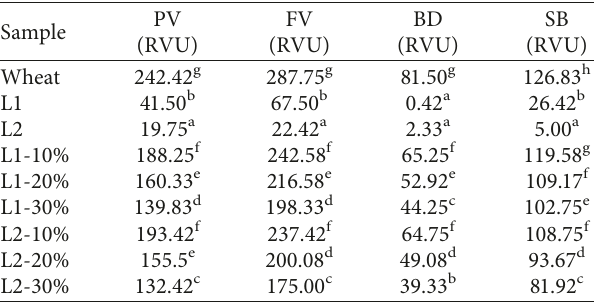
Table 3: Pasting properties of wheat and kañawa flours and their